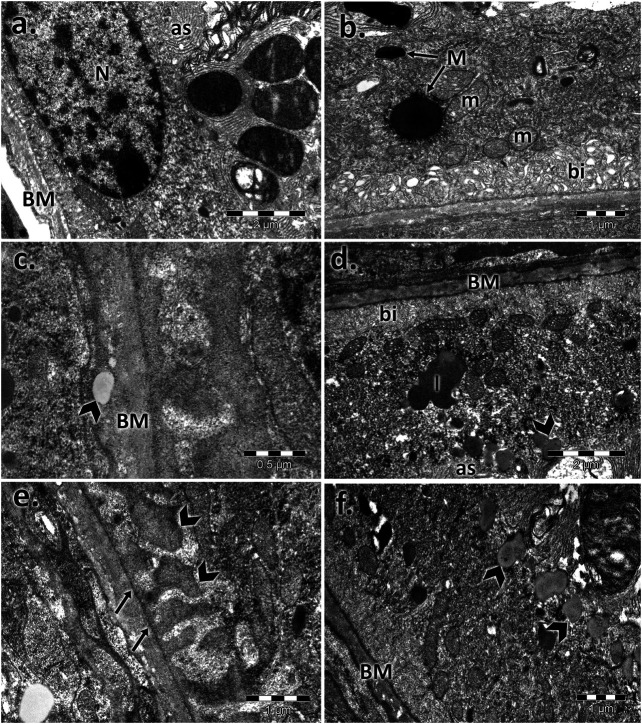
Electron micrographs showing the ultrastructural features of the retinal pigment epithelium (RPE) of the aged female retina. (A)–(B) RPE of the female control, showing the normal aspect of the nucleus (N), mitochondria (m), melanin granules (M), Bruch’s membrane (BM), marked basal infolding (bi), and wide apical sheaths surrounding the photoreceptor outer segments; (C)–(F) RPE of the aged female, showing ultrastructural changes of the RPE cells highlighted by the thickened basal membrane (BM), lipid drops into the membrane (arrowhead) (C); lipofuscin granules (l), and lipids (arrowheads) clustered in the apical sheath area (as) (D); localized thickening of Bruch’s membrane on the RPE side and fingerlike extensions of the amorphous material (arrows) (E); lipids (arrowheads) clustered in the apical sheaths area (F). Figures are representative of n = 10 electron micrographs for each individual/group.